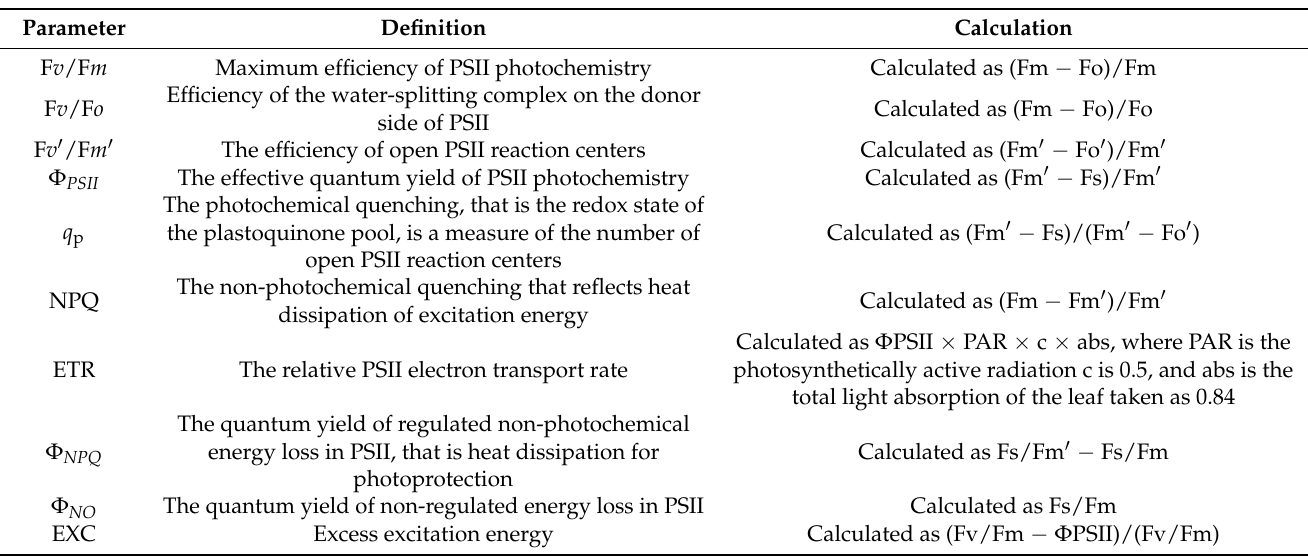
Table 1. Definitions of the chlorophyll fluorescence parameters calculated from the five main chlorophyll fluorescence parameters listed in Table